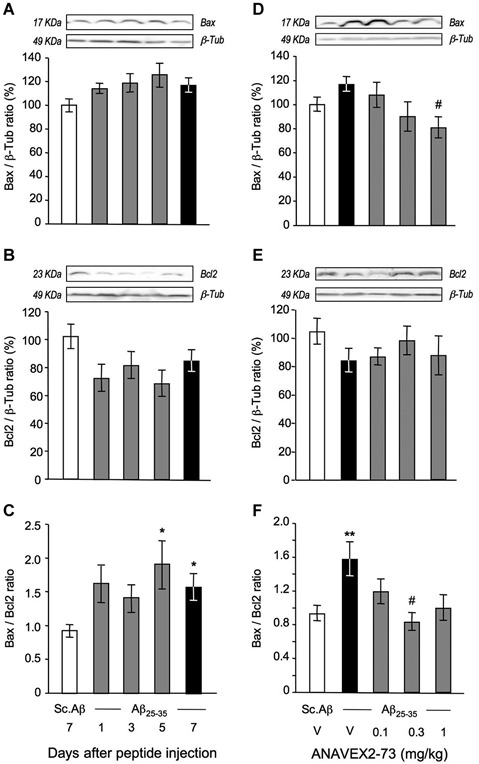
ANAVEX2-73 protected against Aβ25–35-induced increase in Bax/Bcl-2 ratio in the mouse hippocampus. (A–C) Mice were sacrificed at 1, 3, 5 and 7 days after Aβ25–35 injection and Bax and Bcl-2 contents determined by western blots. (D–F) Effect of ANAVEX2-73 (0.1–1 mg/kg IP) on Bax and Bcl-2 levels, 7 days after Aβ25–35 injection. Typical blots are represented above the bar graphs. Mice were injected with ANAVEX2-73 or vehicle before Aβ25–35 peptide (9 nmol). n = 5–15 per groups. F(4,44) = 1.98, p > 0.05 in (A) ; F(4,44) = 1.95, p > 0.05 in (B) ; F(4,44) = 2.66, p < 0.05 in (C); F(4,49)= 3.01, p < 0.05 in (D), F(4,49) = 0.89, p > 0.05 in (E), F(4,49) = 3.09, p < 0.05 in (F). *p < 0.05, **p < 0.01 vs. Sc. Aβ; #p < 0.05 vs. Aβ25–35; Dunnett’s test.